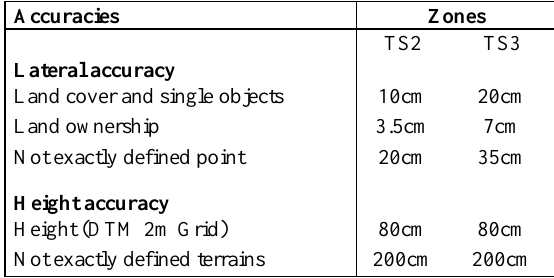
Figure 6. Map of the Science City ETH Zurich test area generated from UAV images